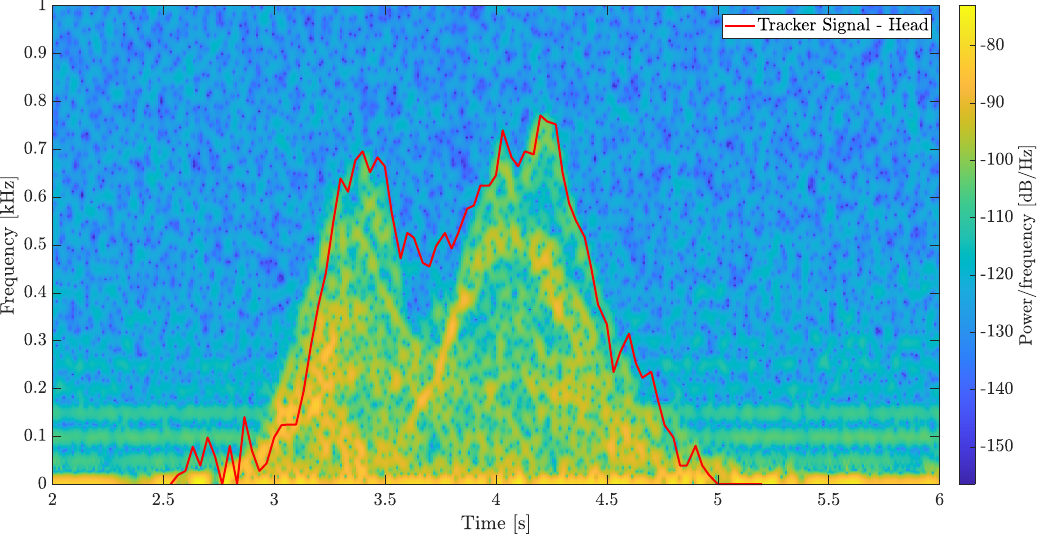
Figure 10. Presentation of the measurement results for a sitting man. The spectral signature was measured using the MMW radar, and the red line indicates the data obtained through head tracking in a recorded video.